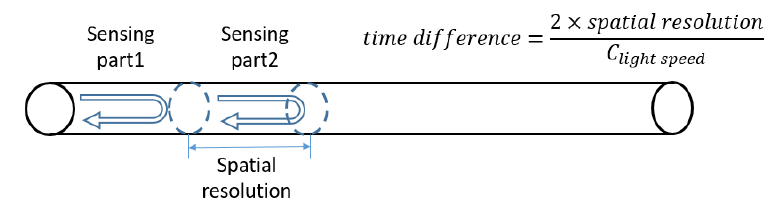
Figure 1. Principle of Optical Time Domain Reflectometry.